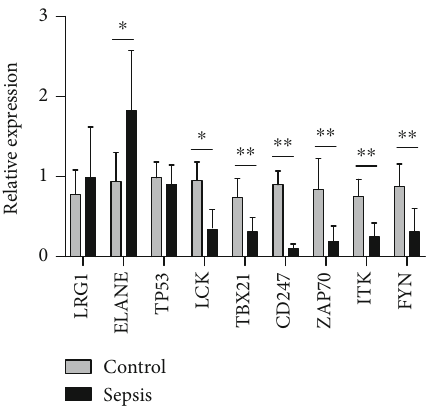
Figure 6: Expression of nine selected key genes was compared between healthy controls and sepsis patients by quantitative real- time PCR. Di ff erences between two groups were analyzed using the t -test. ∗ P < 0 : 05 , ∗∗ P < 0 : 01